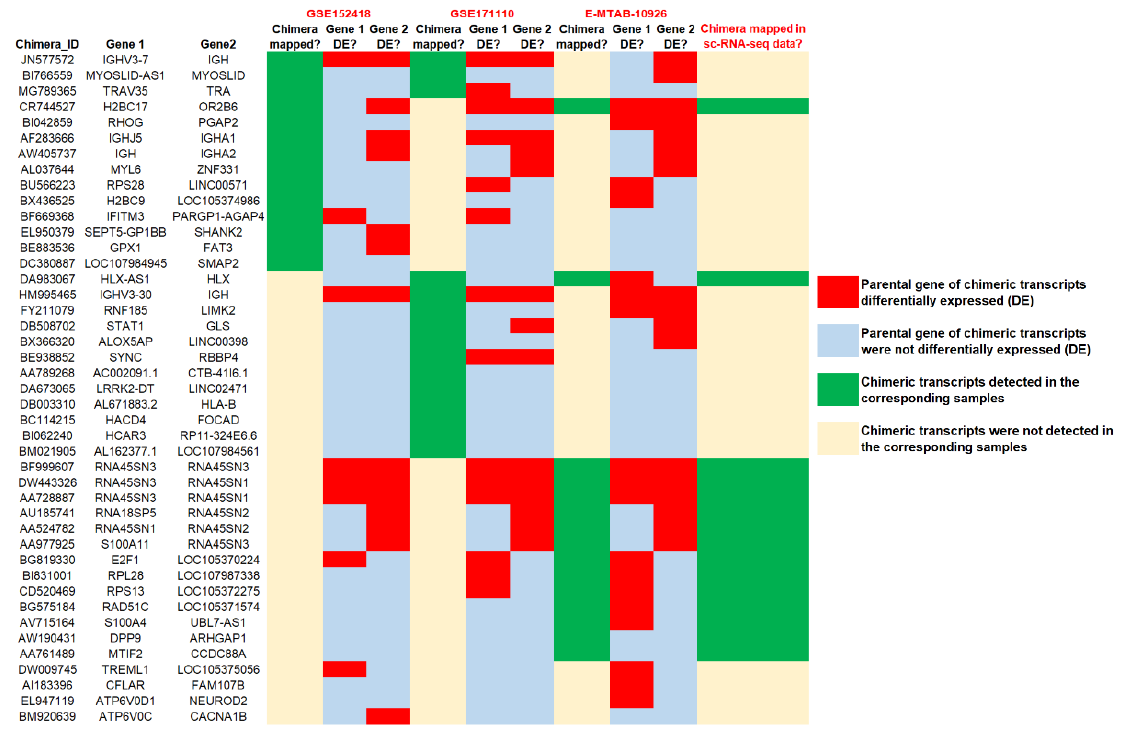
Figure 4. Differential gene expression analysis of the parental genes of severe COVID-19 specific recurrent chimeric transcripts.